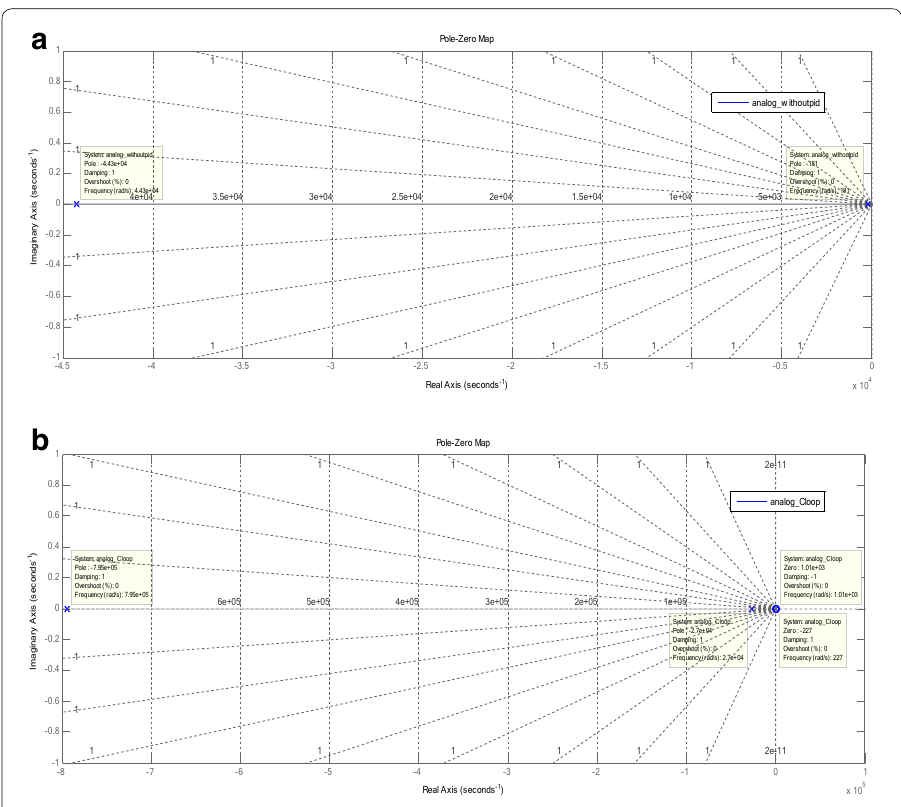
Fig. 16 a – c Analog domain pole-zero plot of BBC in buck mode in open loop ( a ), closed loop with PID ( b ) and PIDN ( c ). d Digital domain pole-zero plot ( Z -plane) of BBC in buck mode in open loop and closed loop with PID and